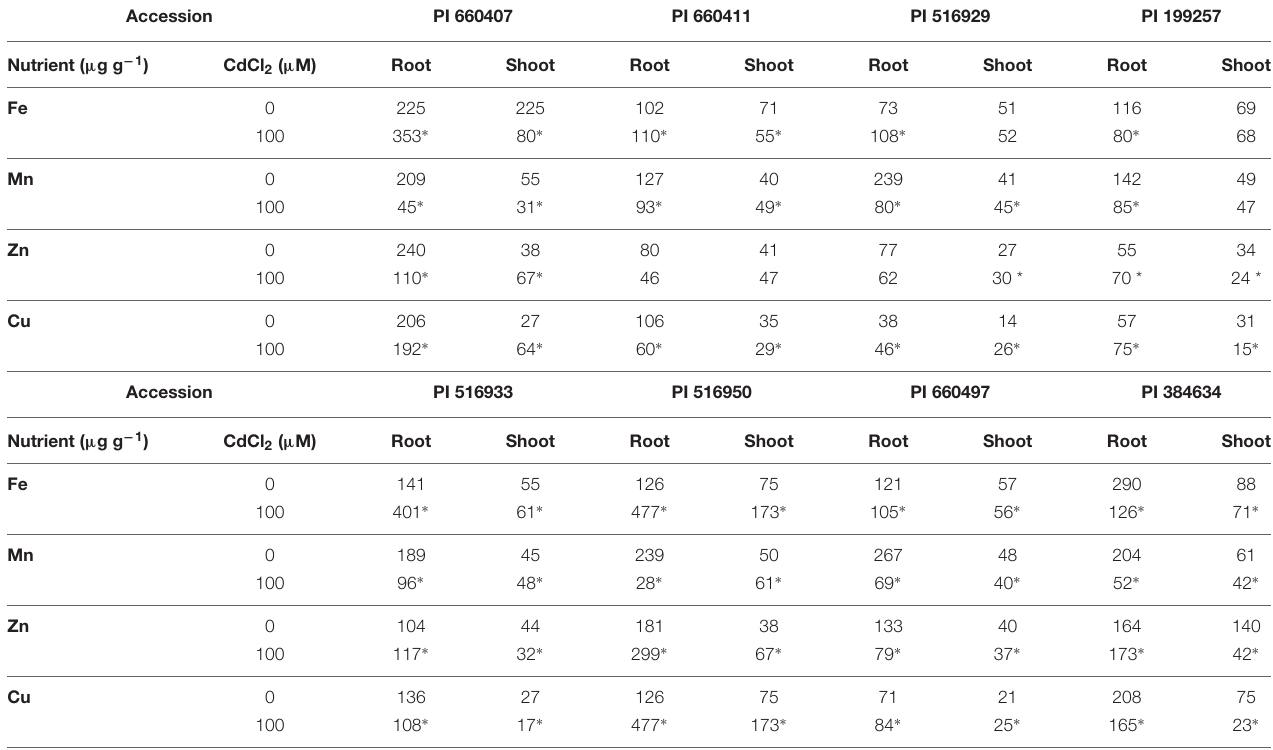
TABLE 3 | Micronutrients content in Cd-tolerant and Cd-sensitive accessions of M. truncatula grown in hydroponic pouches with 0 or 100 µ M CdCl 2 for 12 days. PI 660407